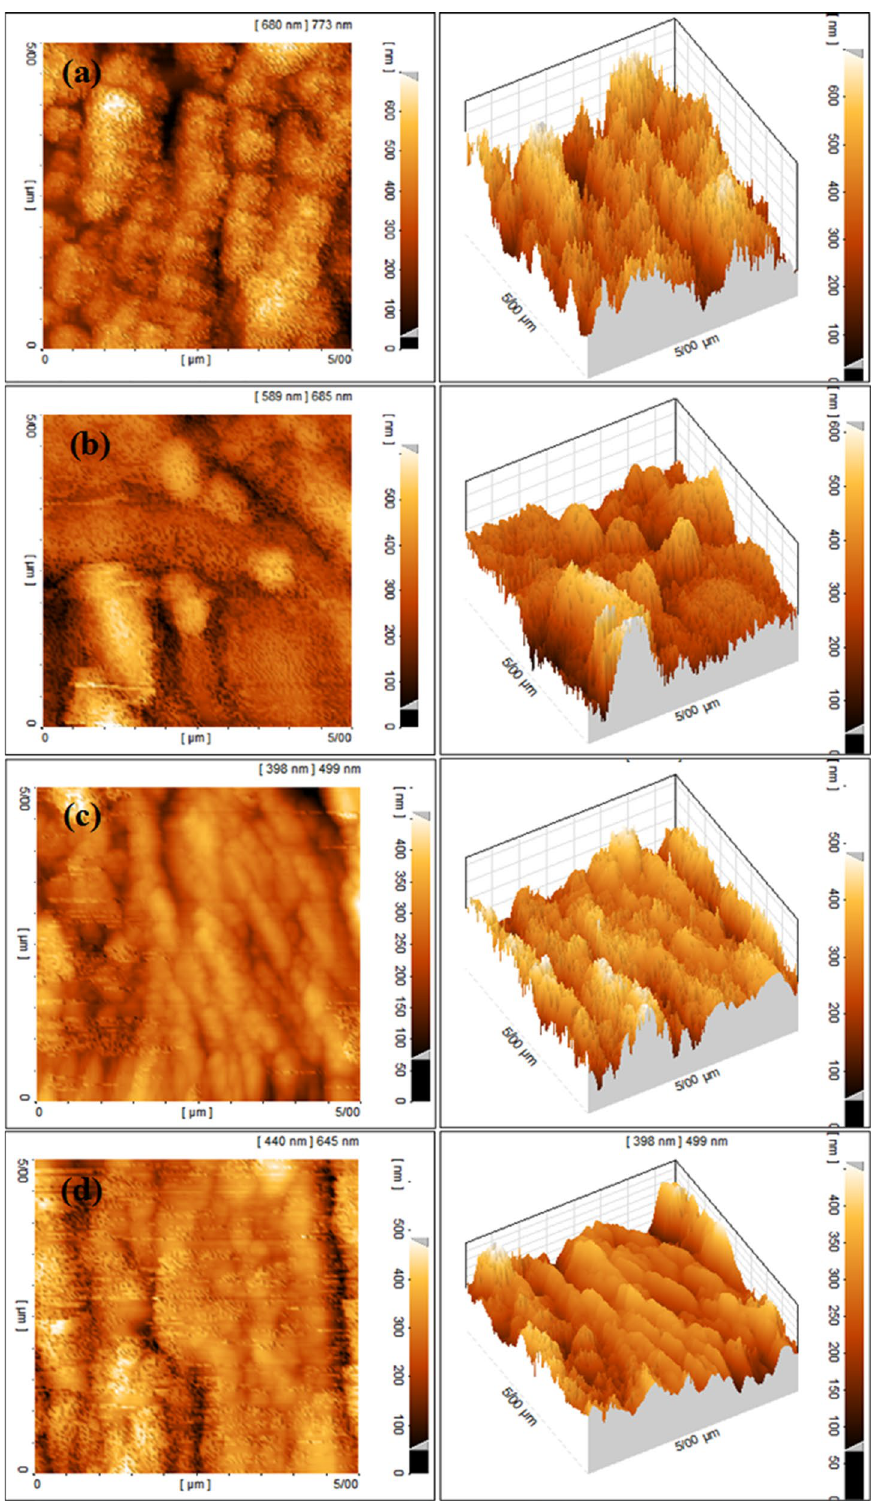
Figure 10. 2D and 3D images of AFM from MS immersed for 3 h in the acid solution containing 0 ppm ( a ), 100 ppm ( b ), 200 ppm ( c ), and 300 ppm ( d )